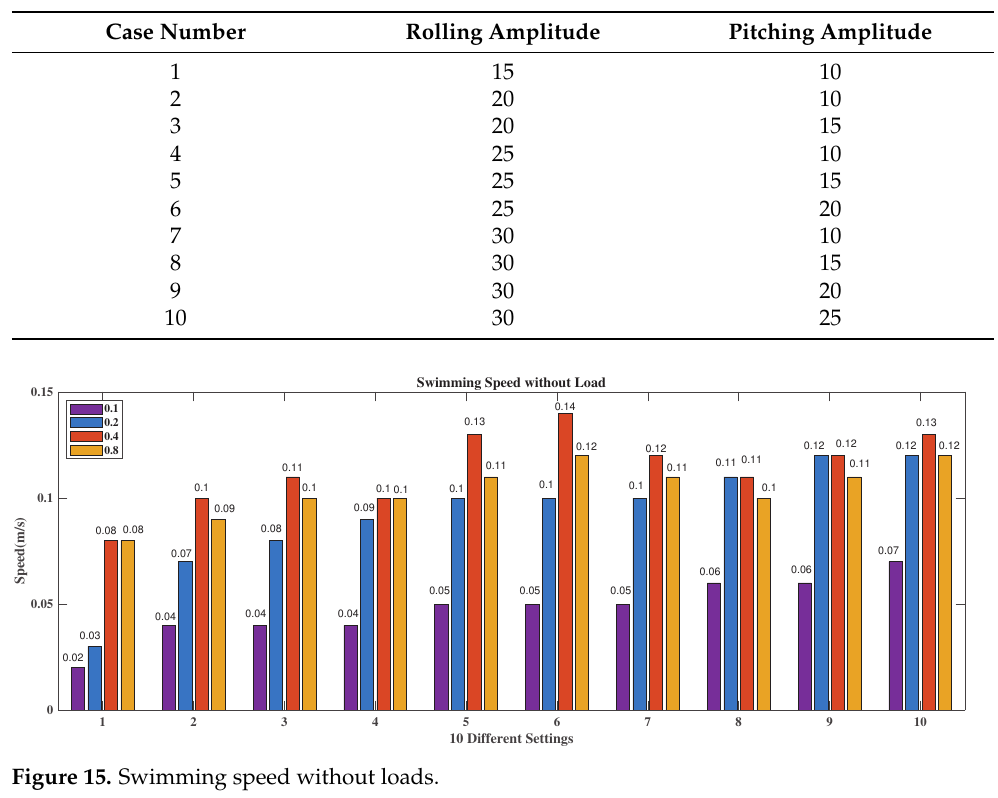
Figure 15. Swimming speed without loads.